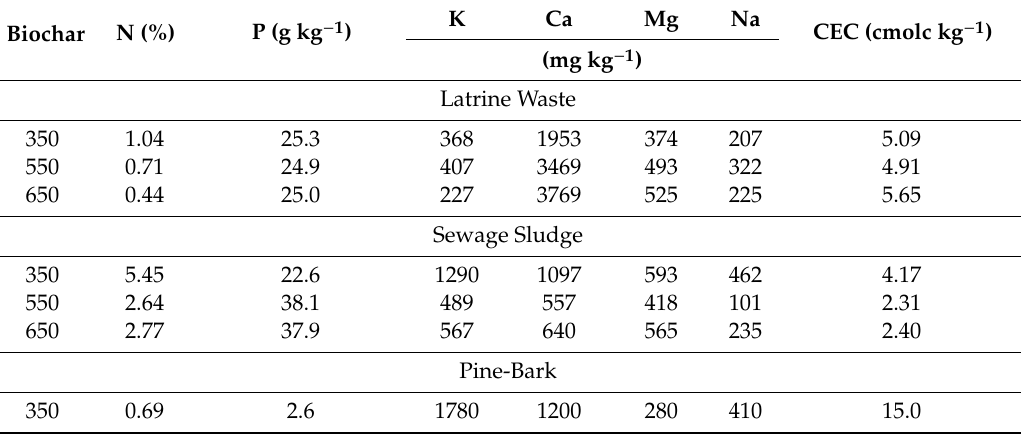
Table 7. Total composition of selected elements and CEC in biochars used in this